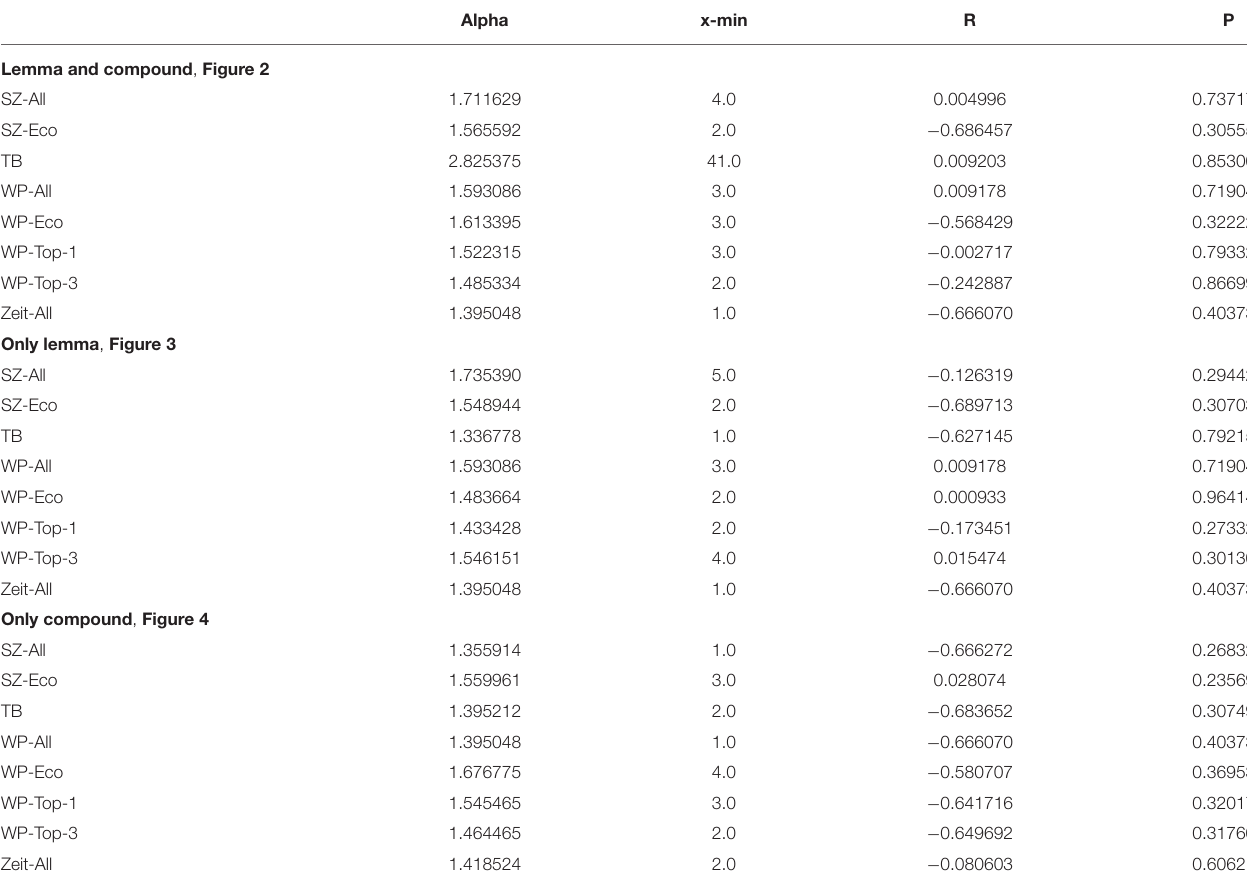
TABLE 5 | Power law goodness-of-fit tests for the distributions from Figures 2 – 4 . Alpha x-min R